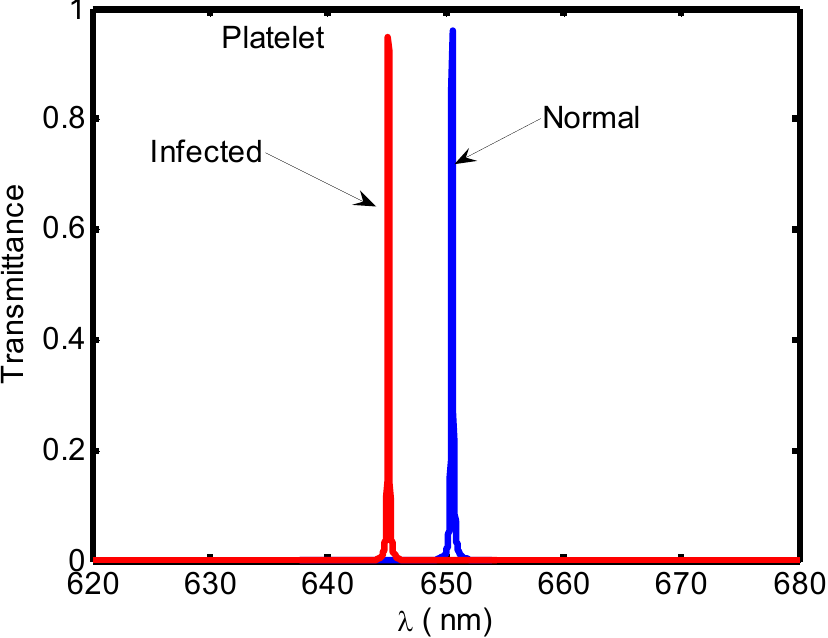
Figure 3. The transmission spectra showing two defect modes inside the PBG of the proposed 1D biophotonic sensor loaded with normal and infected samples containing the platelet component of blood, having a cavity thickness 200 nm at normal incidence.